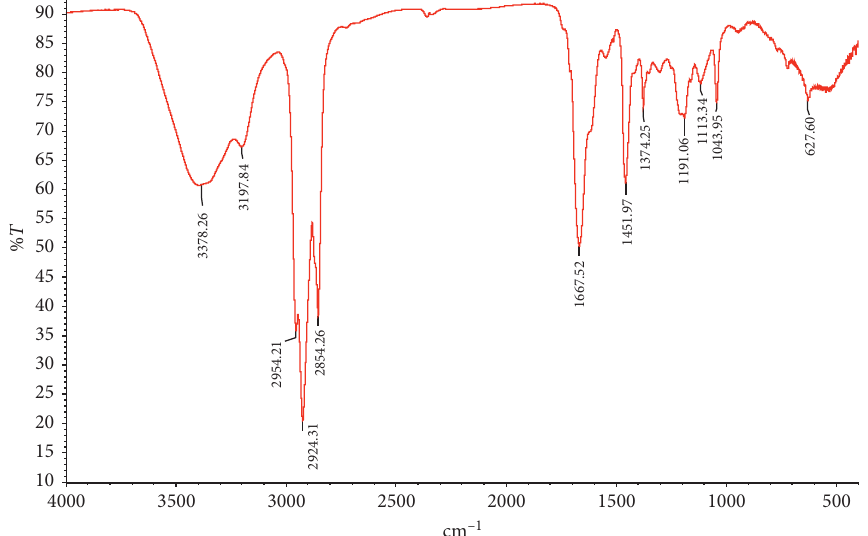
Figure 2: Infrared spectra of the polymeric microspheres.